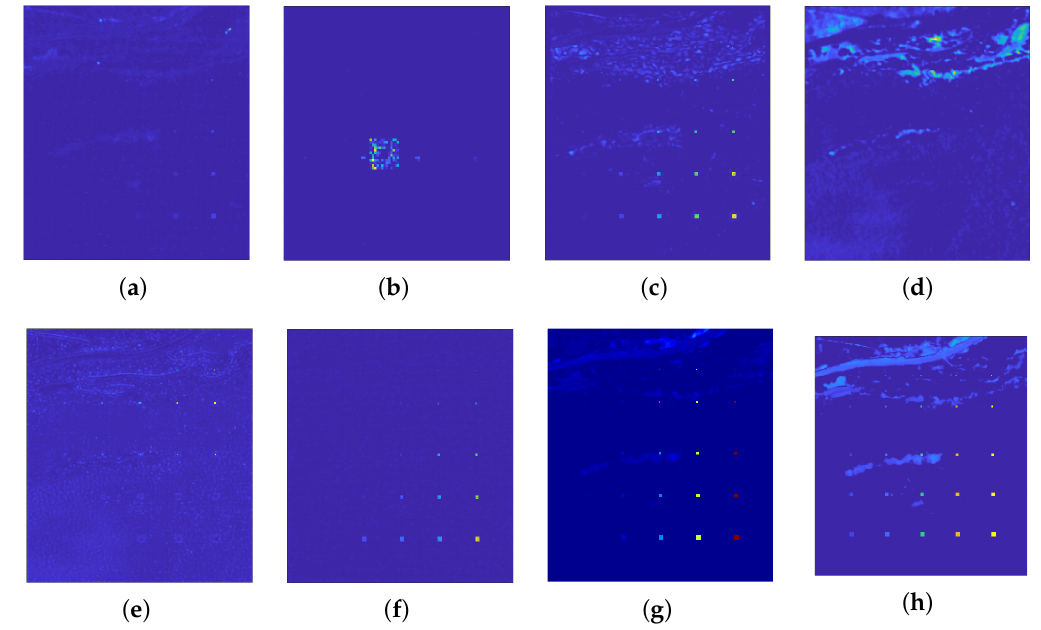
Figure 8. Two-dimensional maps of detection results by different algorithms for the simulated dataset.